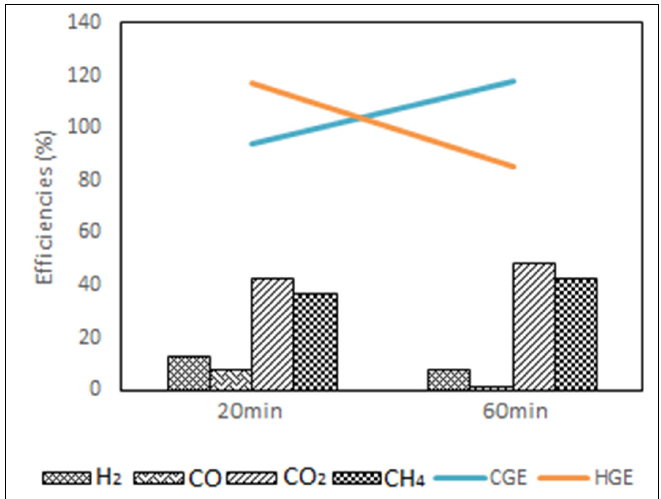
Figure 17. In fl uence of residence time on gas composition and process e ffi ciencies. Figure 17. Influence of residence time on gas composition and process